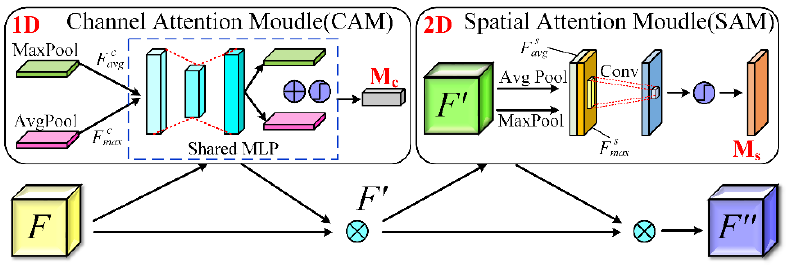
Figure 5. CBAM attentional mechanisms.